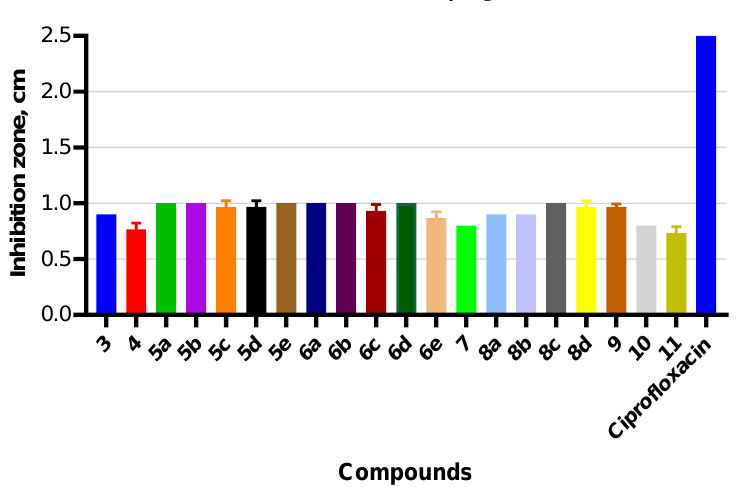
Figure 7. Antibacterial activity against B. subtilis of compounds 3 – 11 and control antibiotic Ciprofloxacin. Data are shown as mean ± SD from three experimental replicates.